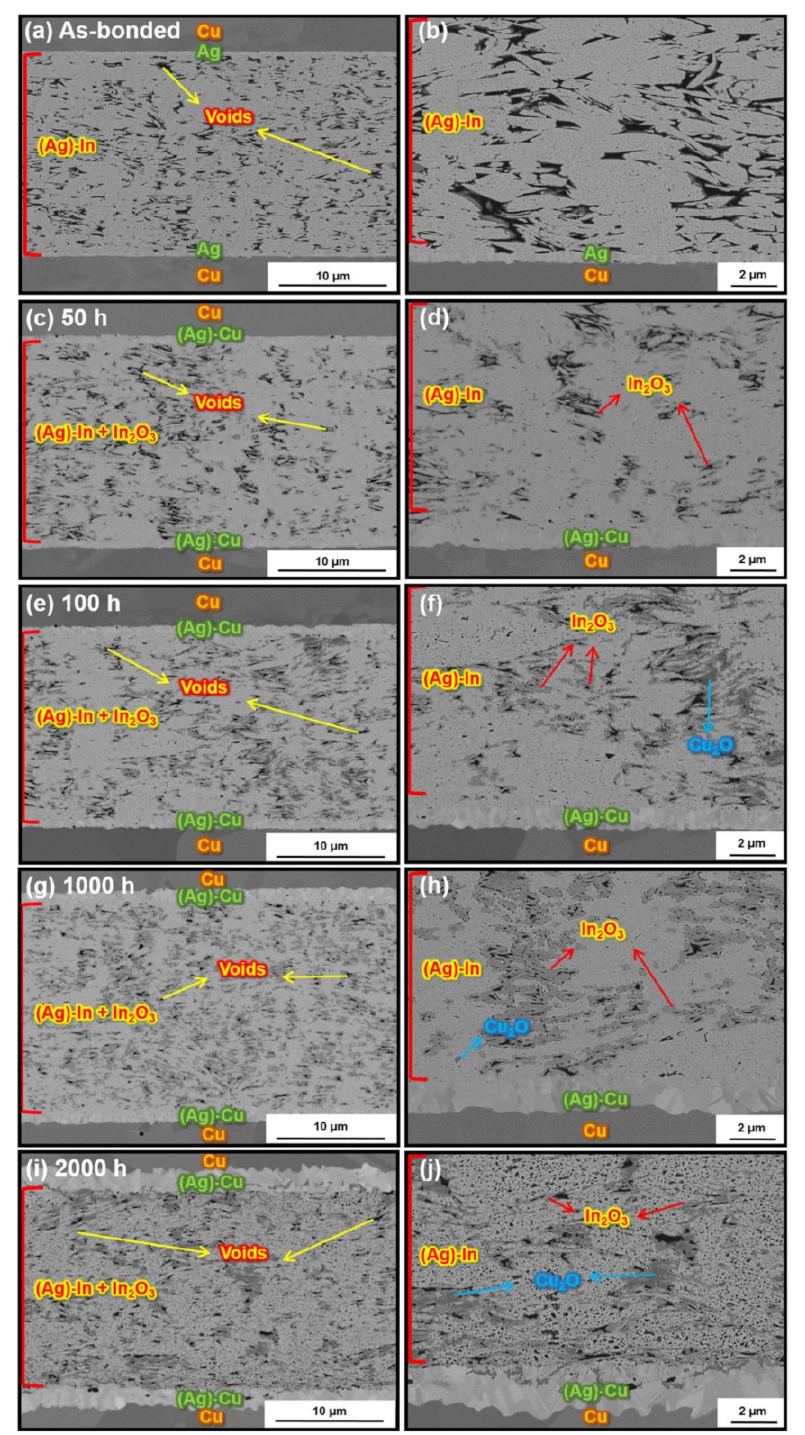
Figure 11. SEM images of the cross-section microstructure of the sintered Ag–In alloy joints bonded at 20 MPa after HTS at 300 ◦ C for the ( a ) as-bonded joints and sintered joints after HTS for ( c ) 50 h, ( e ) 100 h, ( g ) 1000 h, and ( i ) 2000 h. Magnified images of ( a , c , e , g ), and ( i ) are shown in ( b , d , f , h ), and ( j ),